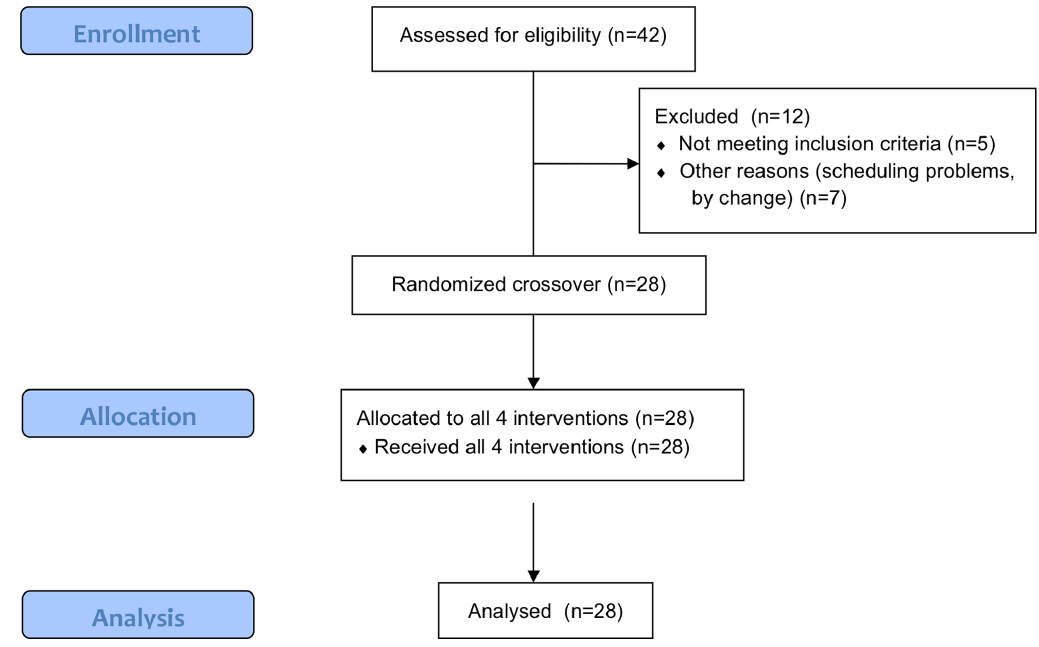
Figure 1. Flow chart (CONSORT).